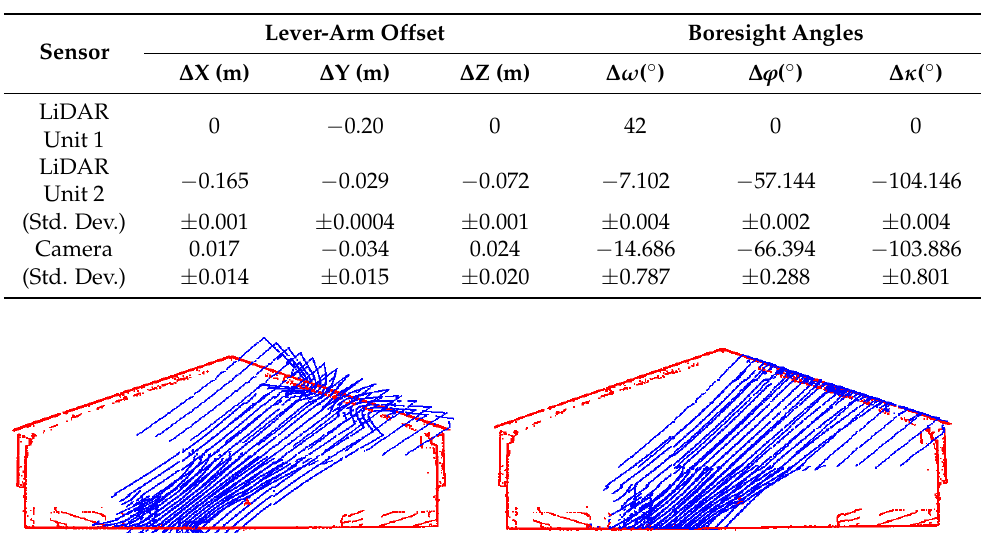
Figure 22. Point clouds from the two LiDAR units for a given scan before ( left ) and after ( right ) system calibration (point clouds are colored by LiDAR unit). Table 3. Estimated mounting parameters relating the LiDAR and camera units to the pole coordi- nate frame.